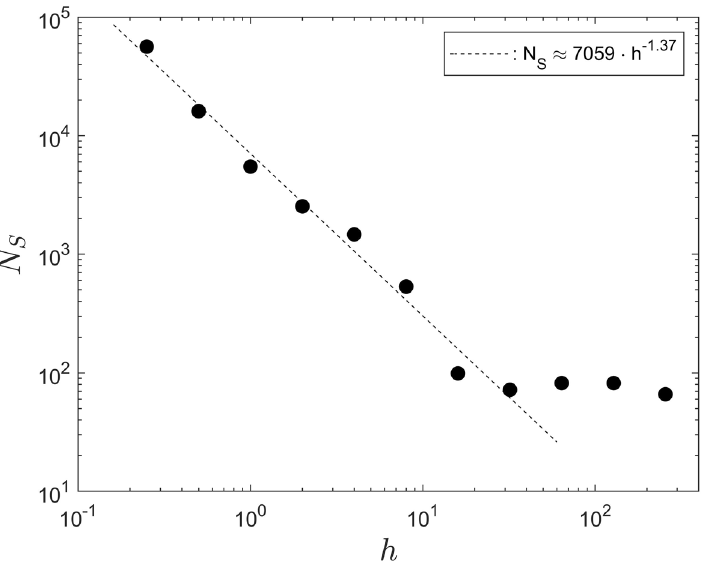
Figure 12. The saturation step, N S as a function of the contagion radius h , for a population P